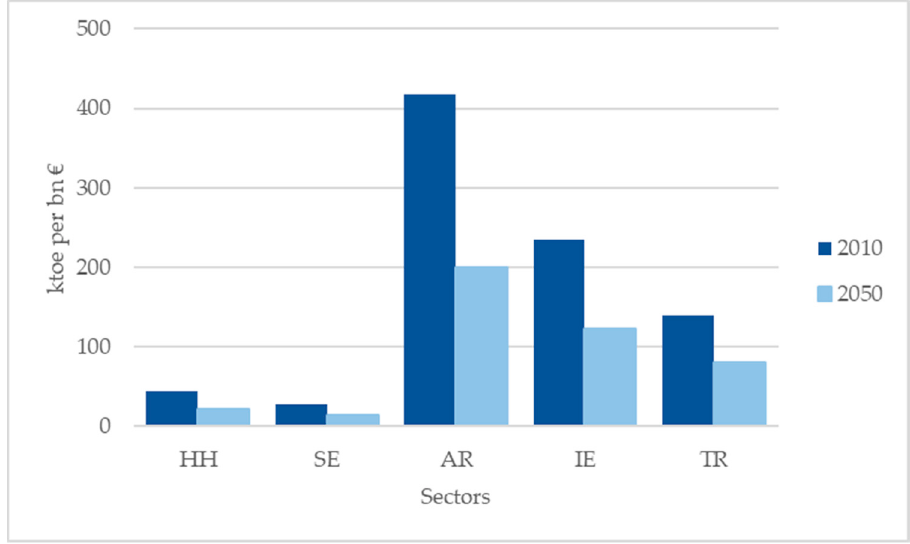
Figure 6. Energy intensities (ktoe/bn €) per group in the Renewable Energy (RE) policy scenario in 2050.